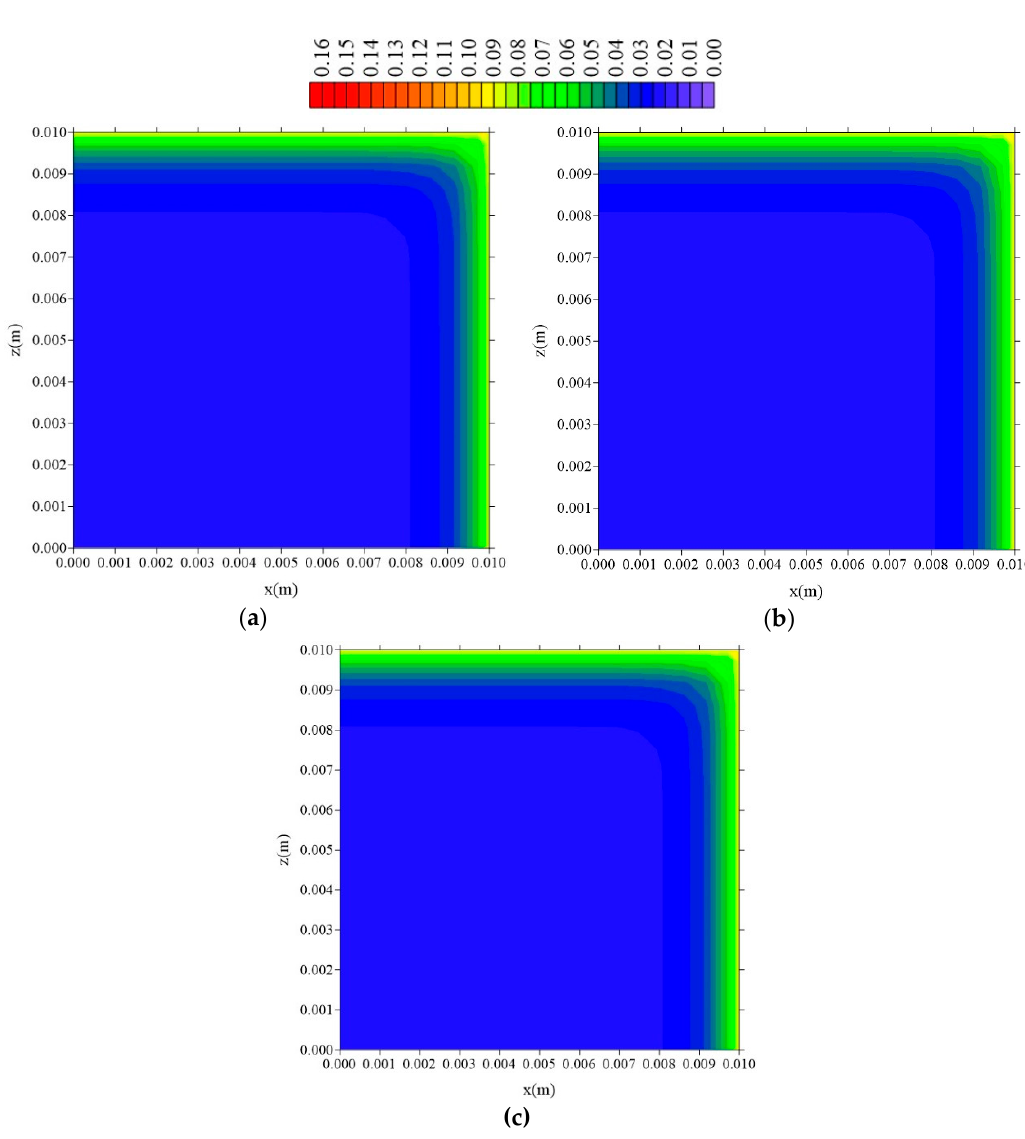
Figure 20. Distribution of the entrapped solute concentration (S in kg/kg) in plan y = R y /2 for different distances l x (t = 211 h; Cases 8, 9, and 10). In which ( a ) l x = 0.01 m; l y = 0.01 m and l z = 0.1 m; ( b ) l x = 0.1 m; l y = 0.01 m and l z = 0.1 m; ( c ) l x = 1 m; l y = 0.01 m and l z = 0.1 m .